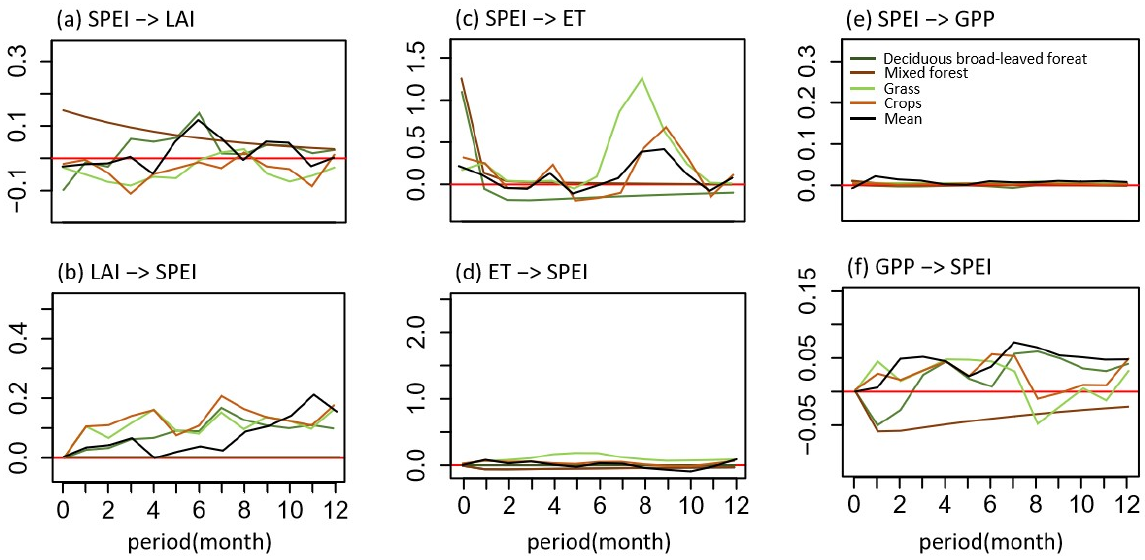
Figure 7. Impulse responses showing the trend with time of SPEI and LAI ( a , b ), ET ( c , d ), and GPP ( e , f ) of different vegetation types after giving shocks to each other. The y -axis represents standard deviation (i.e., the standard deviation that a variable causing another variable at a lag of n months).